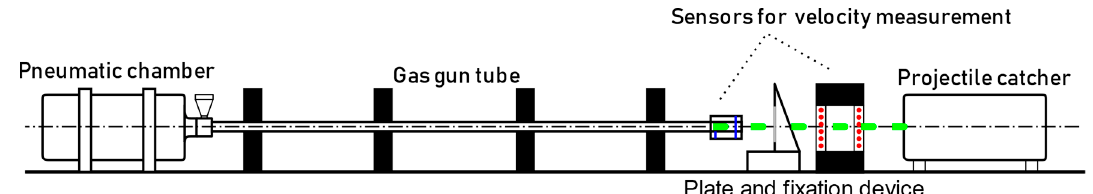
Figure 1. Scheme of experimental setup.